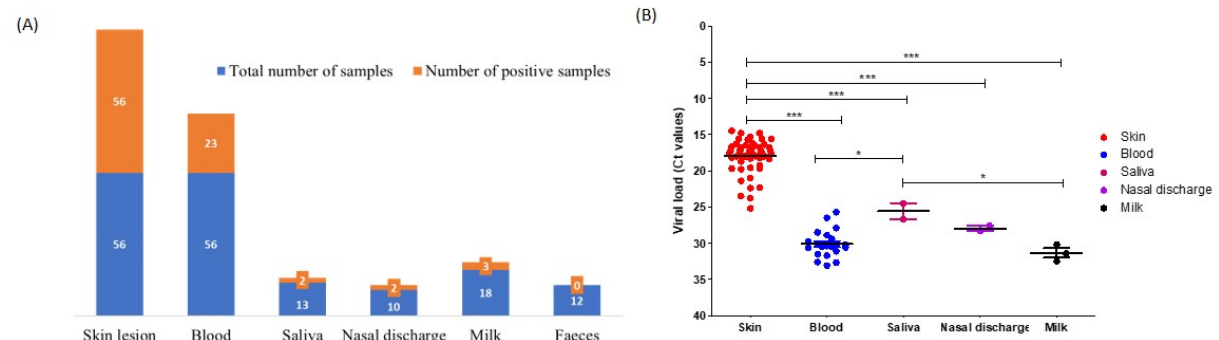
Figure 2. Detection of LSD viral genome with qPCR. ( A ) Bar chart showing the number of positive cases in various samples compared to the total number of samples collected. ( B ) Scatter chart describes the detection limit (calculated from the Ct values at qPCR) for different positive samples. The level of significance was calculated using a one-way ANOVA test (Tukey’s multiple comparison test). *** p ≤ 0.0001; * p ≤ 0.05.